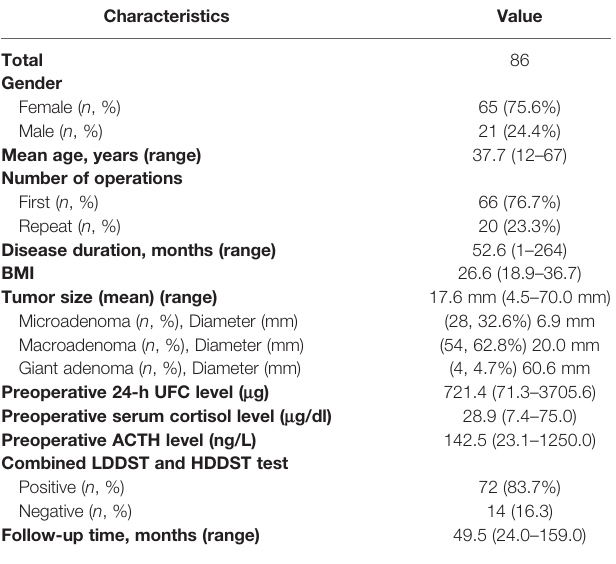
TABLE 1 | Demographic and clinical characteristics of 86 patients with corticotroph adenomas invading cavernous sinus. Characteristics